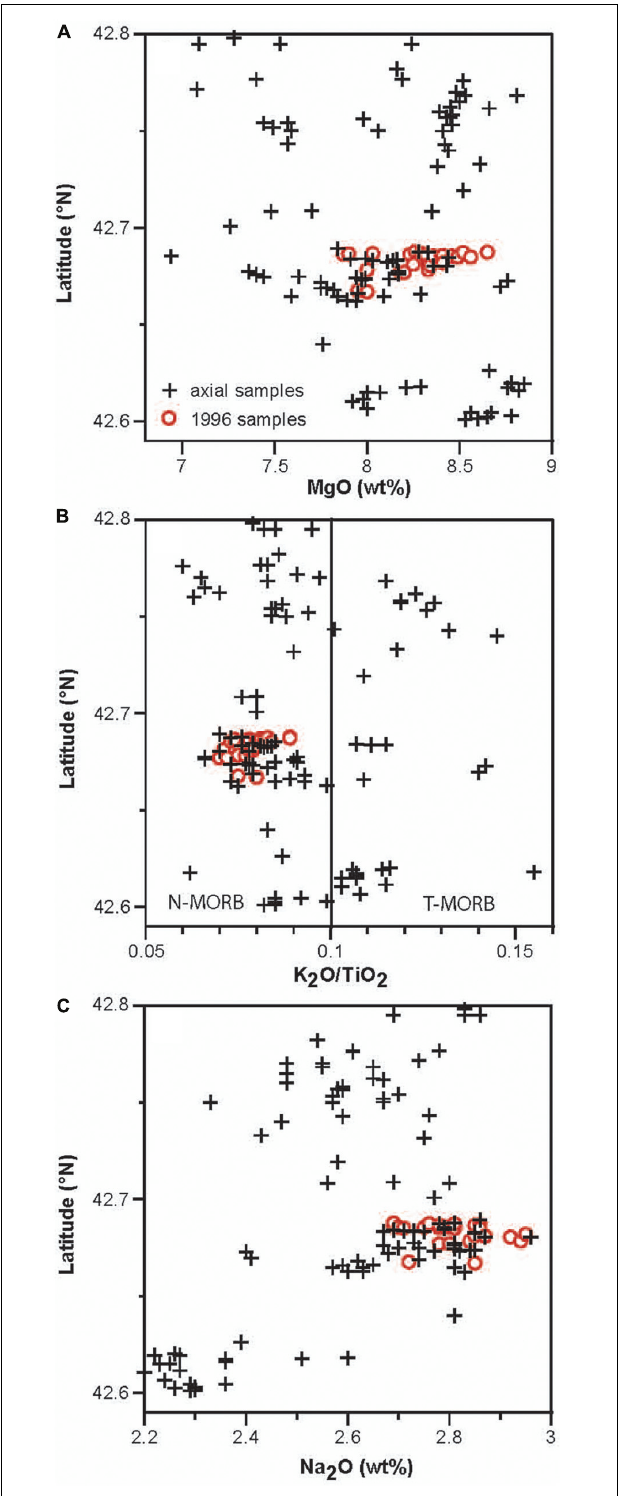
FIGURE 5 | Lava geochemistry as a function of latitude for samples collected from the axial valley and divided into 1996 flow samples and older flow samples. (A) MgO, (B) K 2 O/TiO 2 with values < 0.10 classified as N-MORB and values > 0.10 classified as T-MORB, (C) Na 2